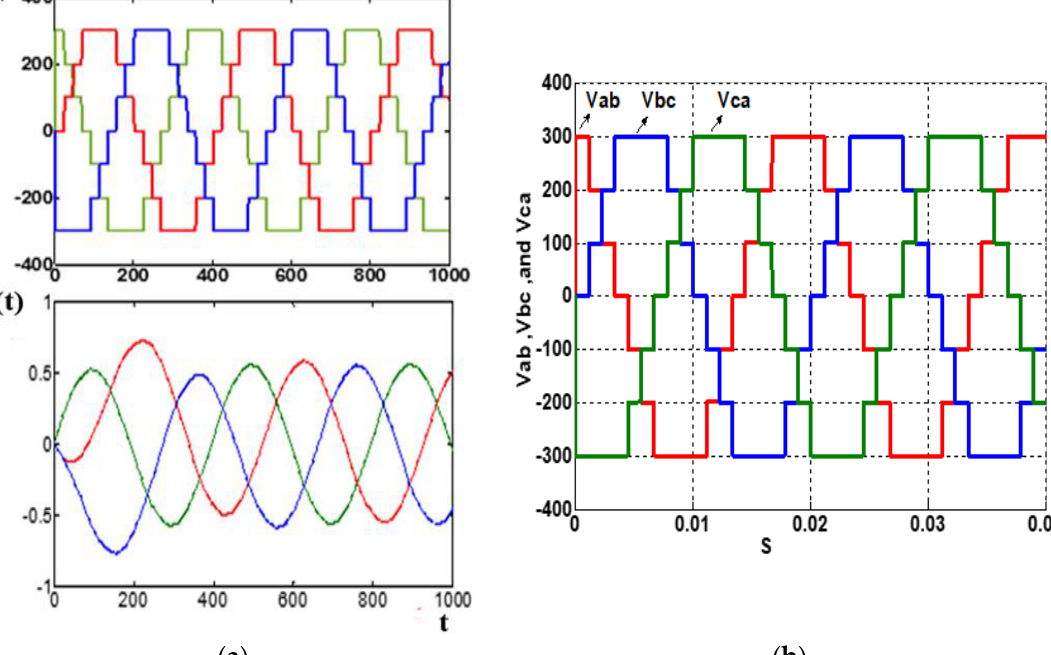
Figure 6. Simulated results for T-NPP. ( a ) From top to bottom: line-to-line voltages and current of the three-phase load. ( b ) Staircase waveforms for the inverter line to line voltages Vab , Vbc , and Vca .